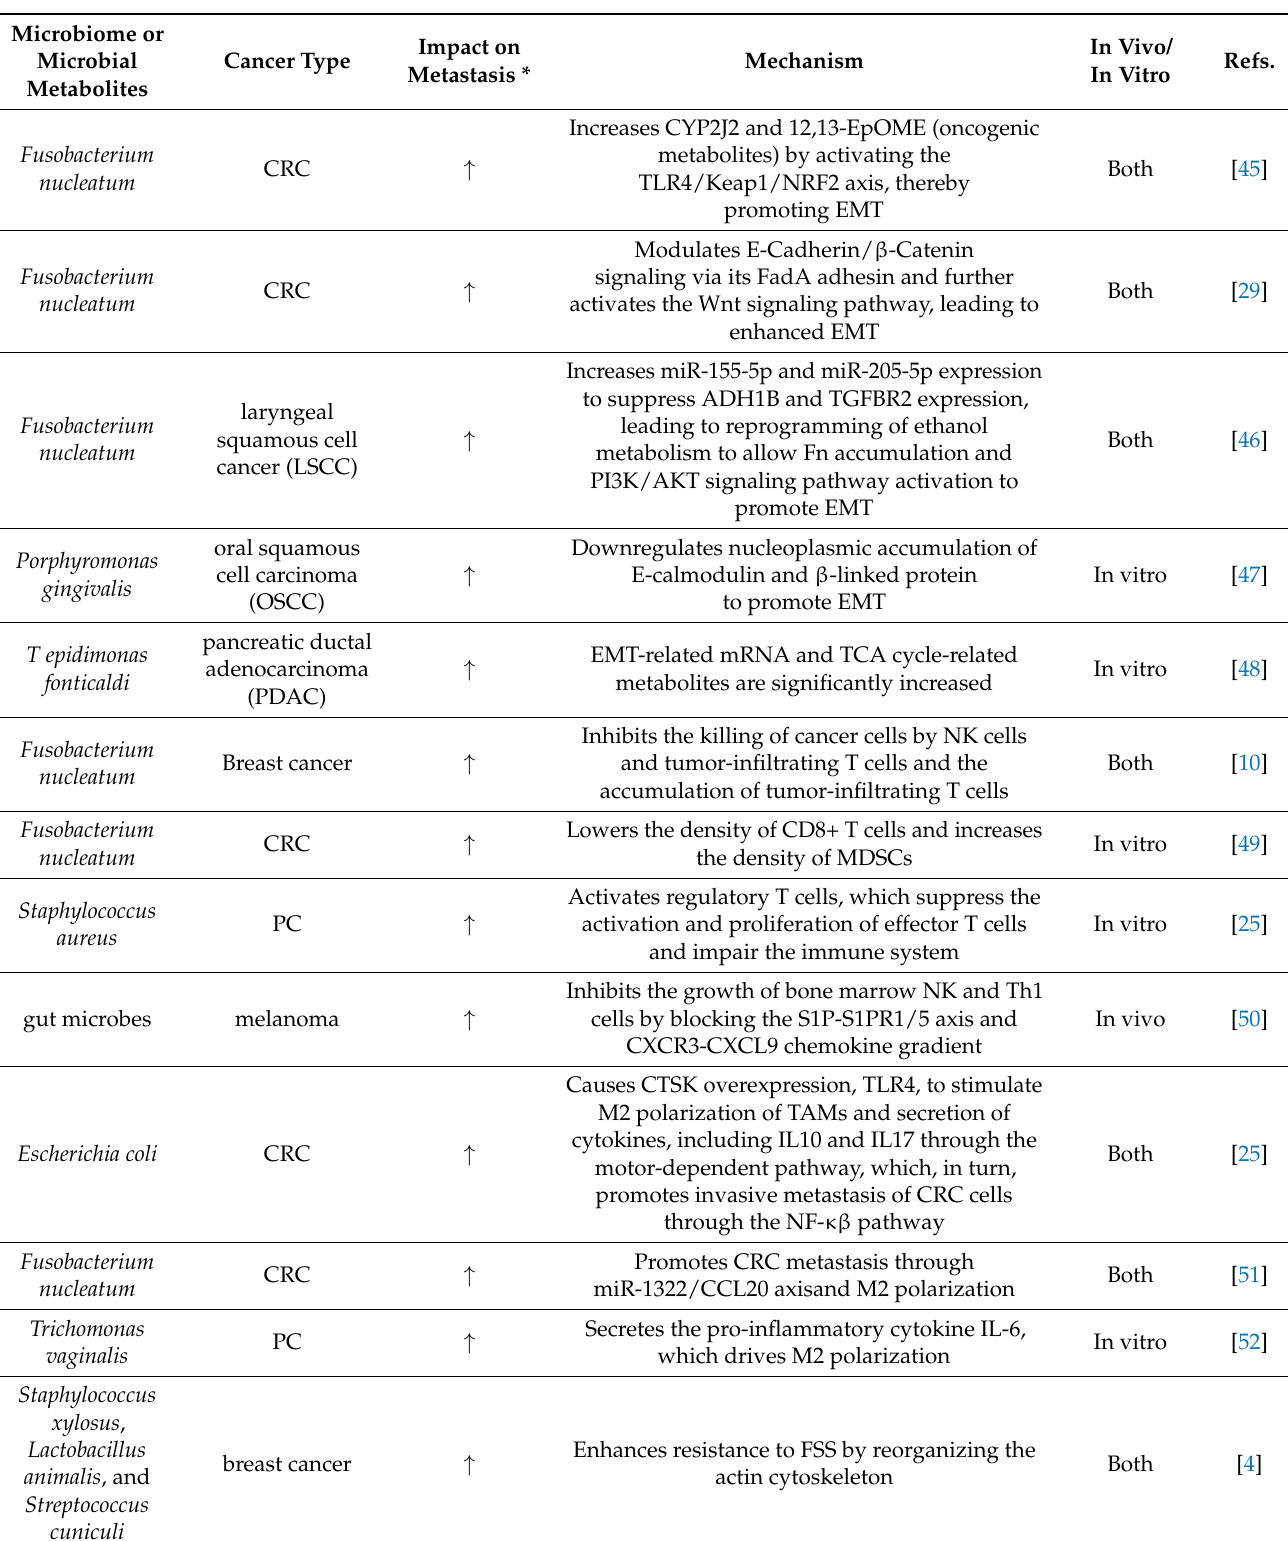
Table 1. Summary of pro-metastatic microbiome